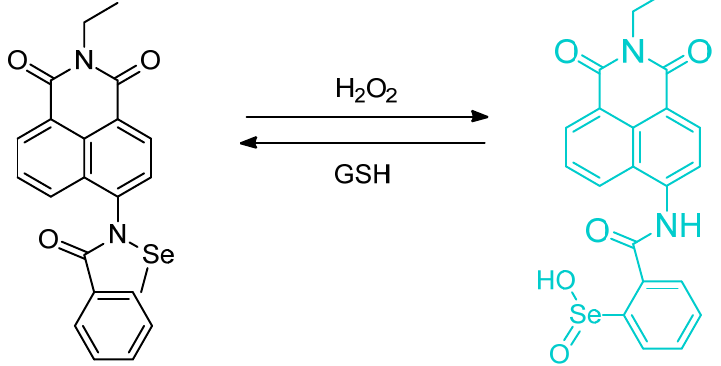
Figure 52. Reaction of NapEb by Ungati et al. with H 2 O 2 and its reversible/resettable reaction with GSH.